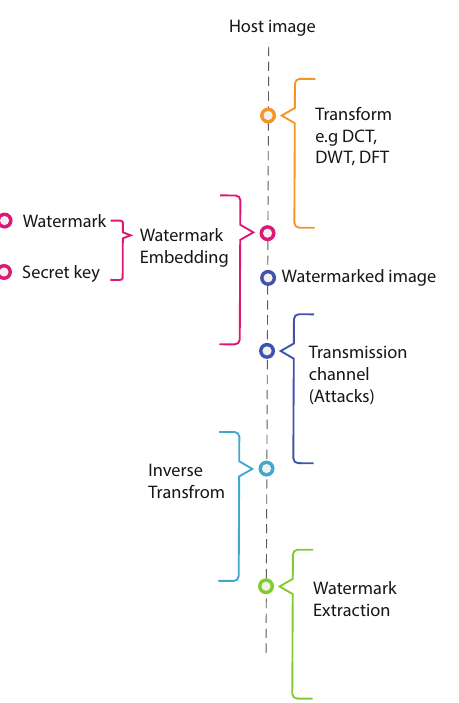
Figure 8. Watermark insertion and detection in the transform